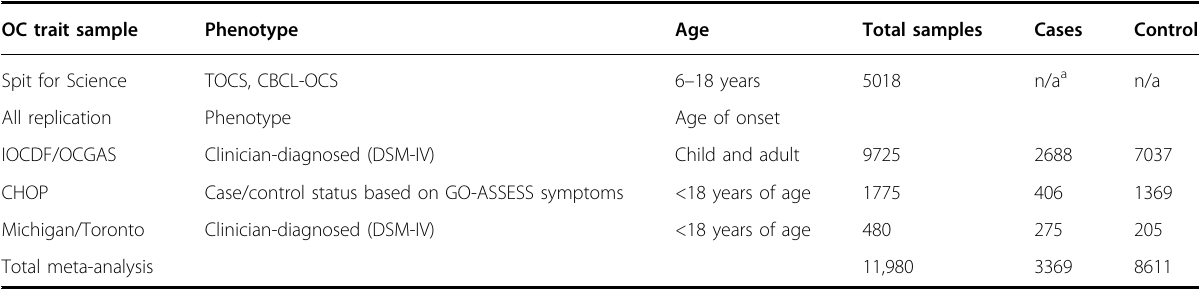
Table 1 Overview of